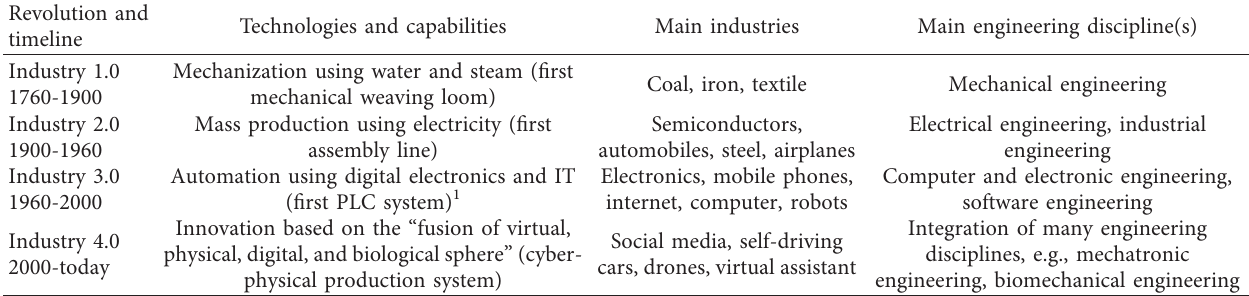
Table 1: Industrial revolution